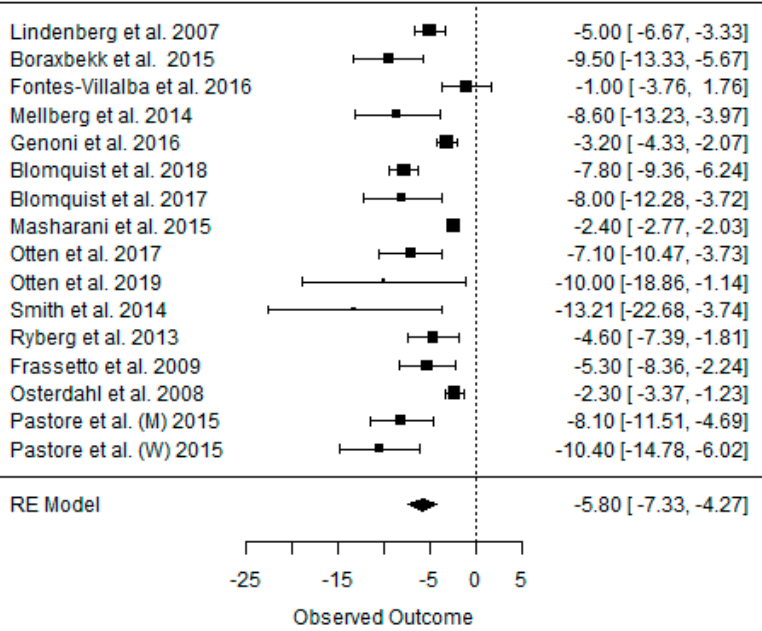
Figure A1. Forest plot of the effect of a PDs on BM (kg) in the short term (weighted mean difference).